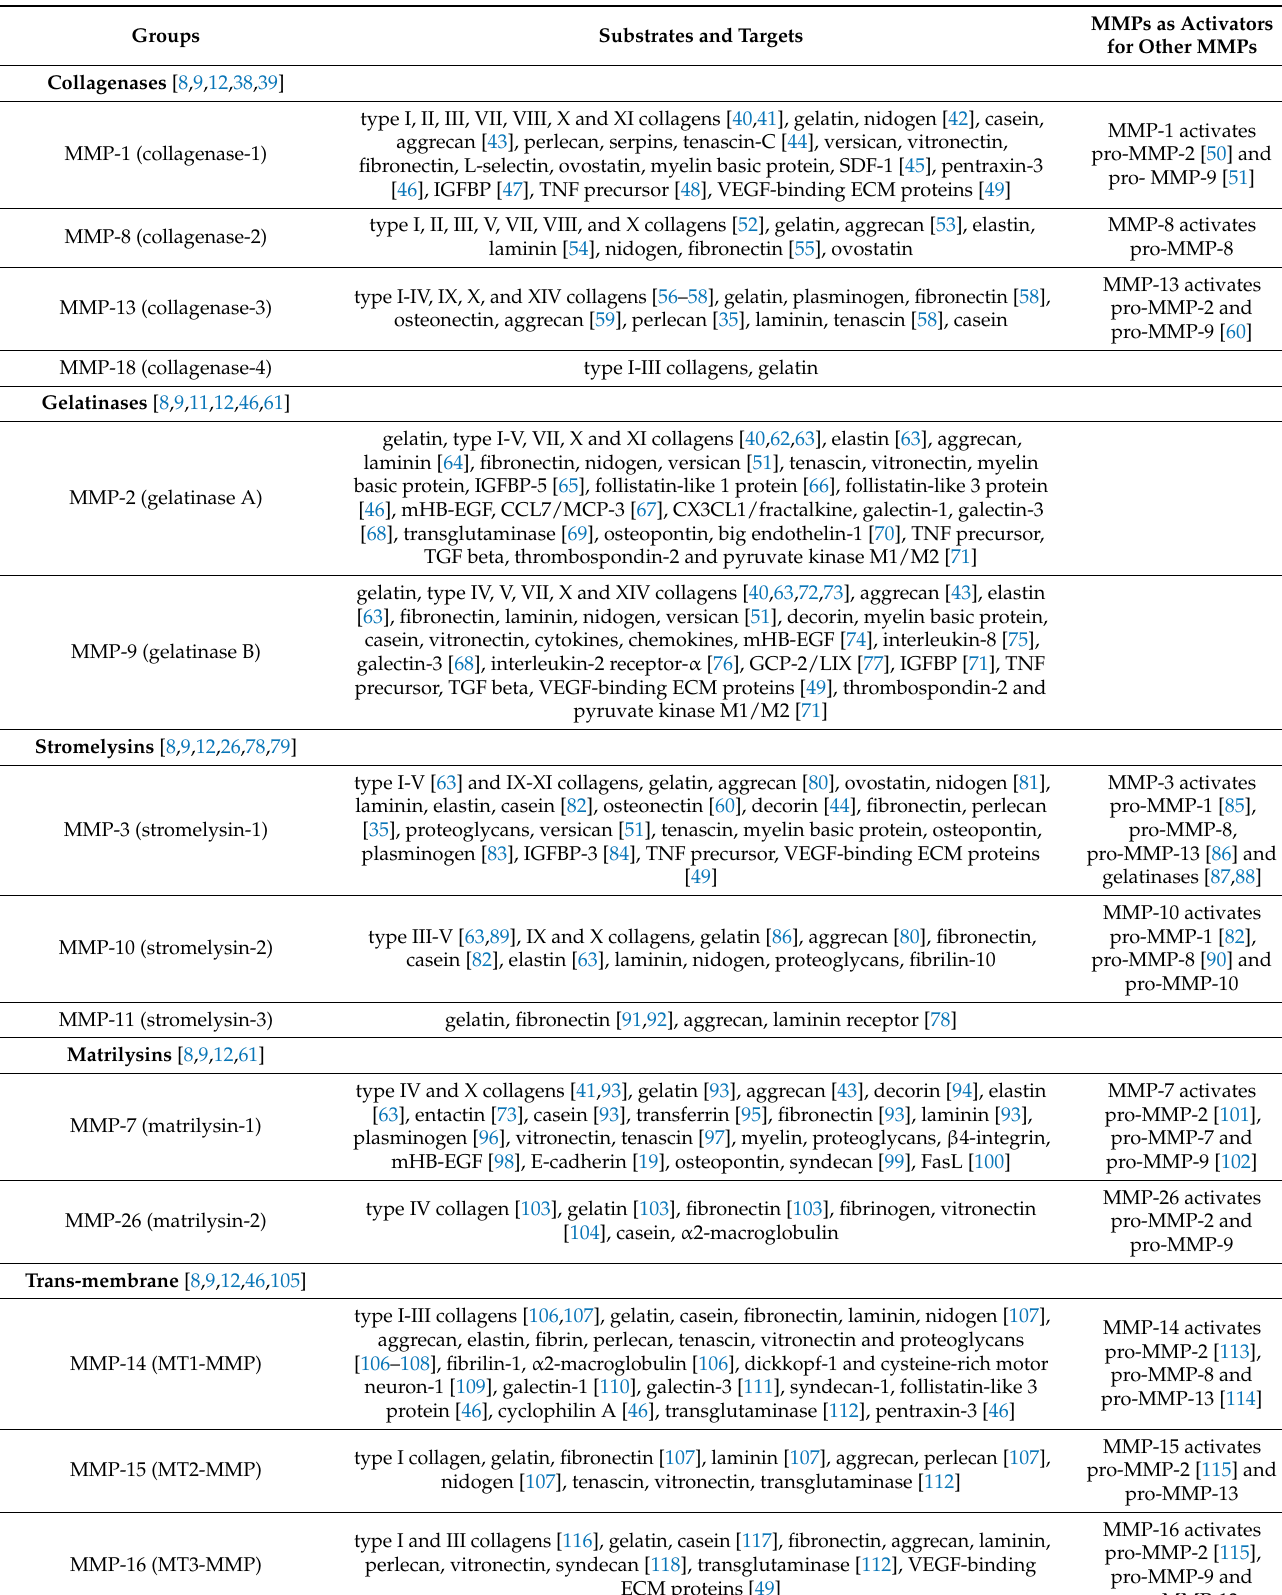
Table 1. MMP classifications and their